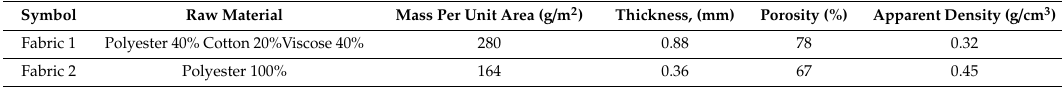
Table 1. Characteristics of tested